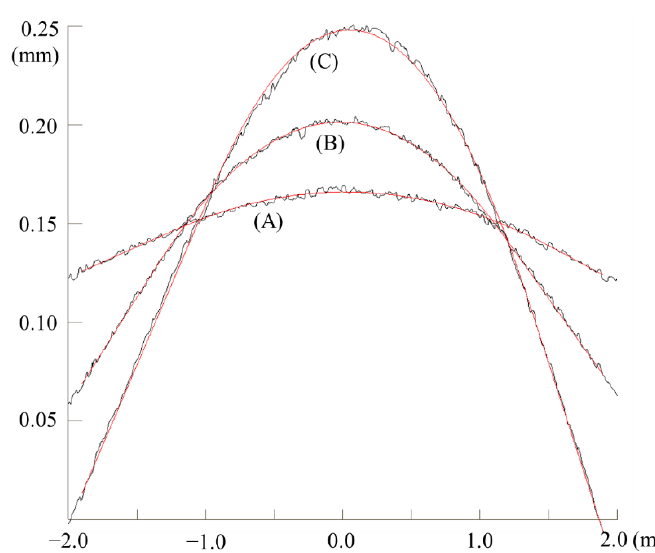
Figure 10. Fitted curves and measured data points of the subtle features on automobile outer panels. The values for the cases, (A), (B) and (C) are given in Table 6.